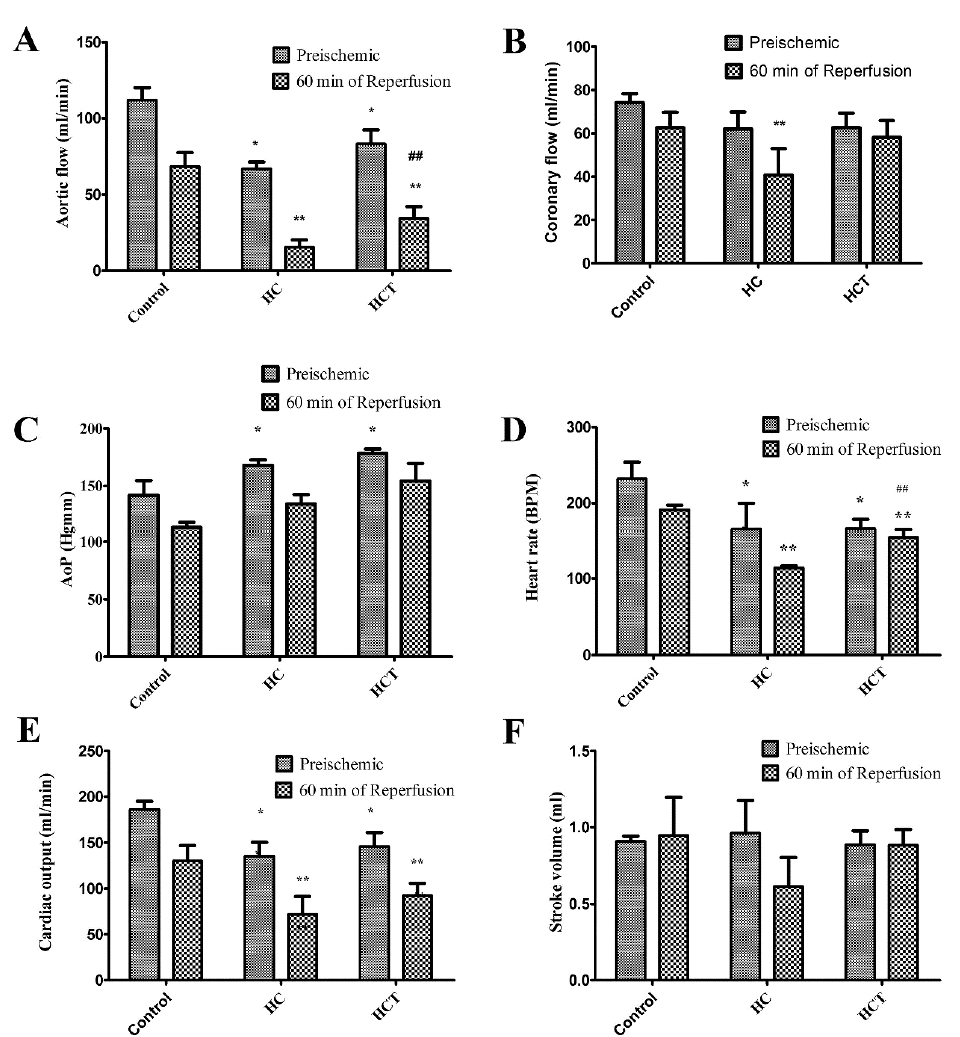
Figure 2. Effect of high cholesterol and WGLL on cardiac function. Hearts were isolated from three groups of animals ( n = 6), defined as follows: non-hypercholesterolemic animals fed with normal chow (control); hypercholesterolemic group fed with 2% cholesterol-supplemented chow (HC); and a group of hypercholesterolemic animals treated with WGLL (HCT). Isolated working hearts harvested from each animal in each group were subjected to global ischemia followed by 120 min of reperfusion (I/R). Cardiac functions were registered before ischemia (preischemic) and 60 min after global ischemia (60 min of reperfusion). Results are shown as average values from each group of rabbits ± SEM of aortic flow (AF, mL/min, A ); coronary flow (CF, mL/min, B ); aortic pressure (AoP, Hgmm, C ); heart rate (HR, beat/min, D ); cardiac output (CO, mL/min, E ); stroke volume (SV, mL, F ). * p < 0.05 compared to the preischemic control; ** p < 0.05 compared to the 60 min of reperfusion control; ## p < 0.05 compared to the 60 min of reperfusion HC.